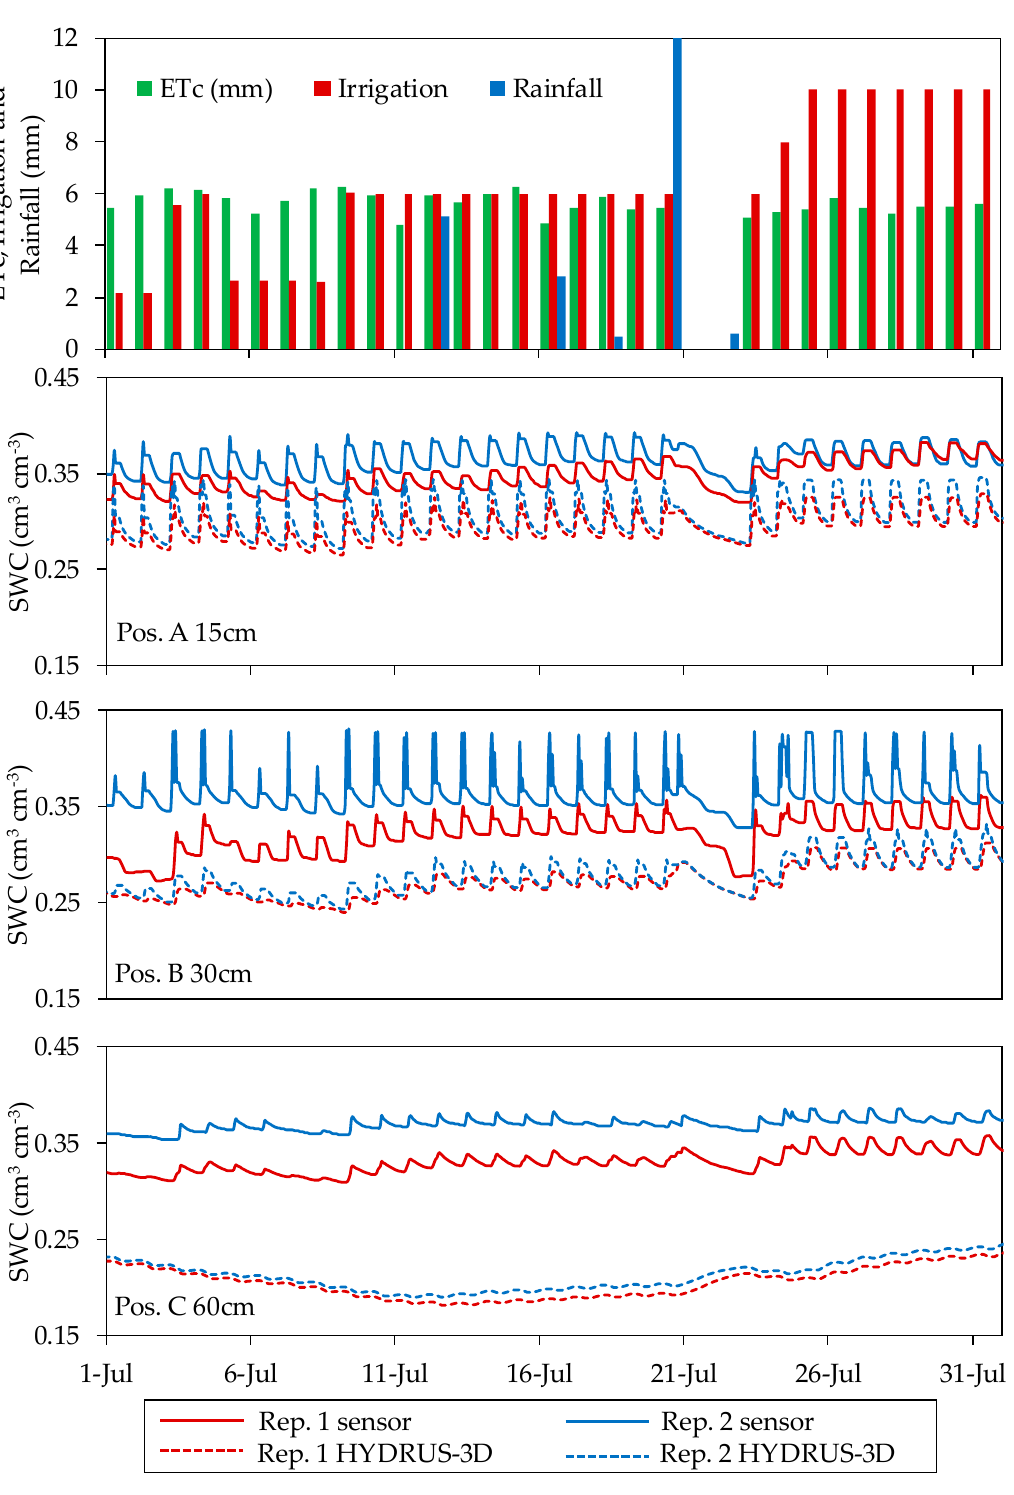
Figure 7. Example of daily behavior of humidity sensors located in position A at the depth of 15 cm, B at the depth of 30 cm, and C at the depth of 60 cm in Plot II in July 2018. For their part, the HYDRUS-3D simulations showed in Figure 8 a similar order of amplitude to that of the sensors for locations A30, A60, B30. However, the median amplitude at A15 simulated by HYDRUS-3D was only 0.0089 cm 3 cm − 3 , one third of that observed by sensors, and also with less variability, with an 80th percentile of 0.0143 cm 3 cm − 3 . The wider oscillation with sensors at A15 consisted of a more intense drop of SWC before irrigation compared with simulation. At this position,